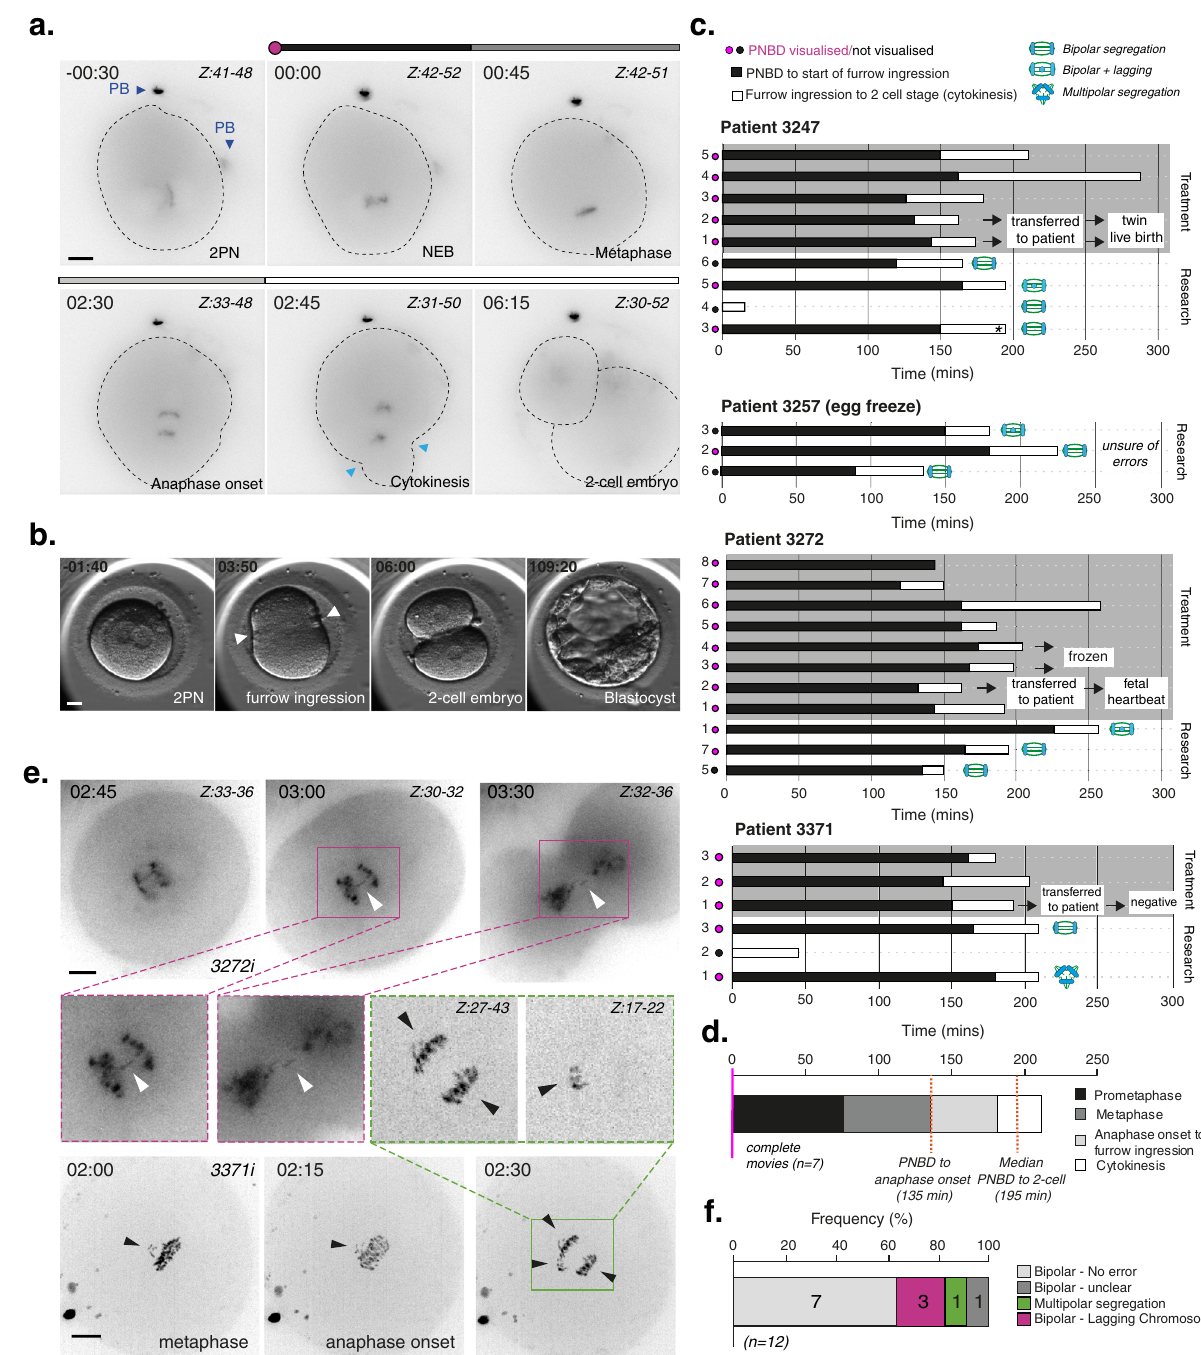
Fig. 1 | Clinical-grade human embryos display high levels of chromosome segregation errors during the fi rst mitotic division. a Time lapse imaging of a representative egg-share-to-researchhumanembryo(3247iii)progressing through the fi rst embryonic mitosis. Chromosomes are visualised using SiR-DNA dye. Z indicatesslicesshownasamaximumintensityprojection.Timeinhours:mins,scale bar 20 µ m. Light blue arrows indicate onset of cleavage furrow ingression, PB= polar body. b Representative movie stills showing clinical EmbryoScope monitor- ing of an egg-share-to-research embryo used for patient treatment. White arrows denote onset of cleavage furrow ingression. Scale bar: 20 µ m, time in hours:mins. c History plots of egg-share embryos; half used for patient treatment (grey back- ground) and half donated to research (white background). Black and white bars denotetimingsofcriticalstagesduringthe fi rstembryonicmitosis.Pink/blackdots indicate whether pronuclear break down (PNBD) was visualised during fi lming.